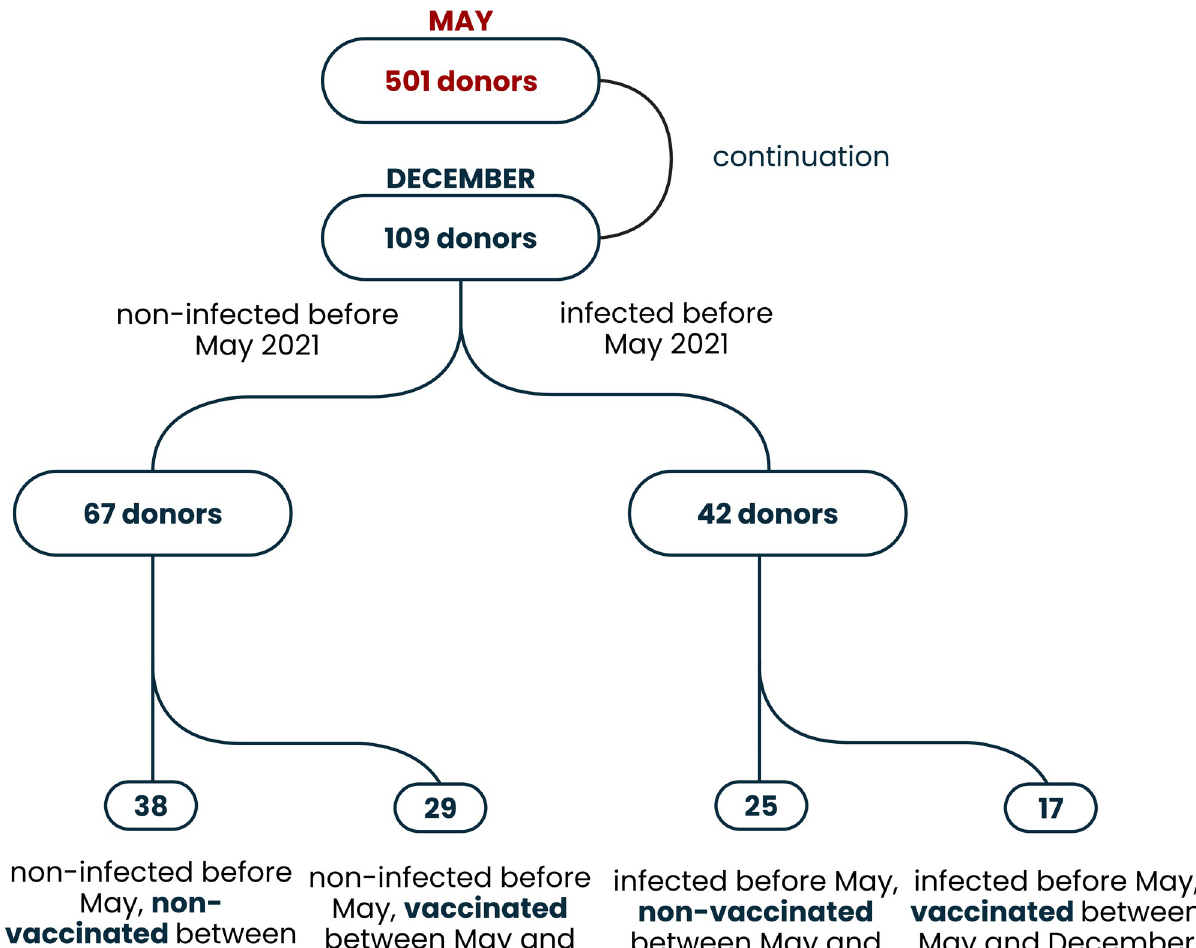
Fig 1. The flow chart presenting recruitment of participants.